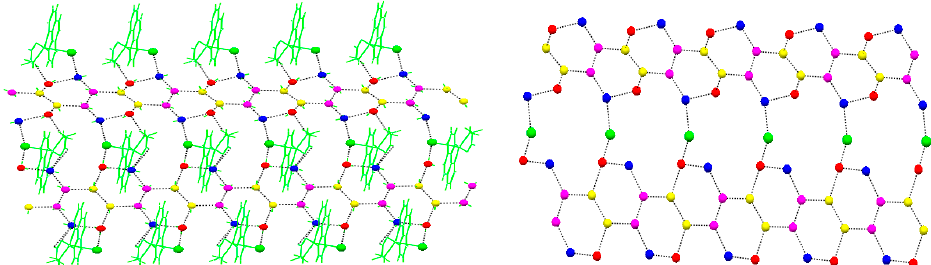
Figure 1. ( Left ) Depicting the hydrogen bond interaction of [CuCl(phen) (H 2 NCH 2 COO)] with the water cluster; ( Right ) View of the water–chloride T12(3) aggregate. The water clusters and Cl atoms are depicted as a ball and stick model for clarity. Colors are as follows: blue, O1w; red, O2w; pink, O3w; yellow, O4w; black dashed, hydrogen bond; green and capped stick, [CuCl(phen)(H 2 NCH 2 COO)] group and hydrogen atom.